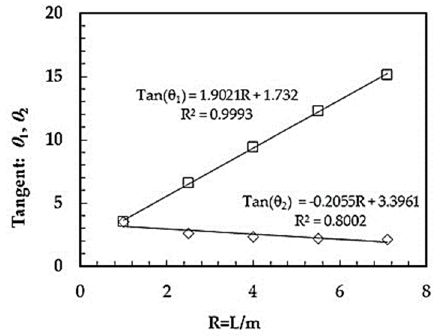
Figure 3. Evolution of the tangents of 𝜃 (cid:2869) and 𝜃 (cid:2870) as function of the R-ratio values.